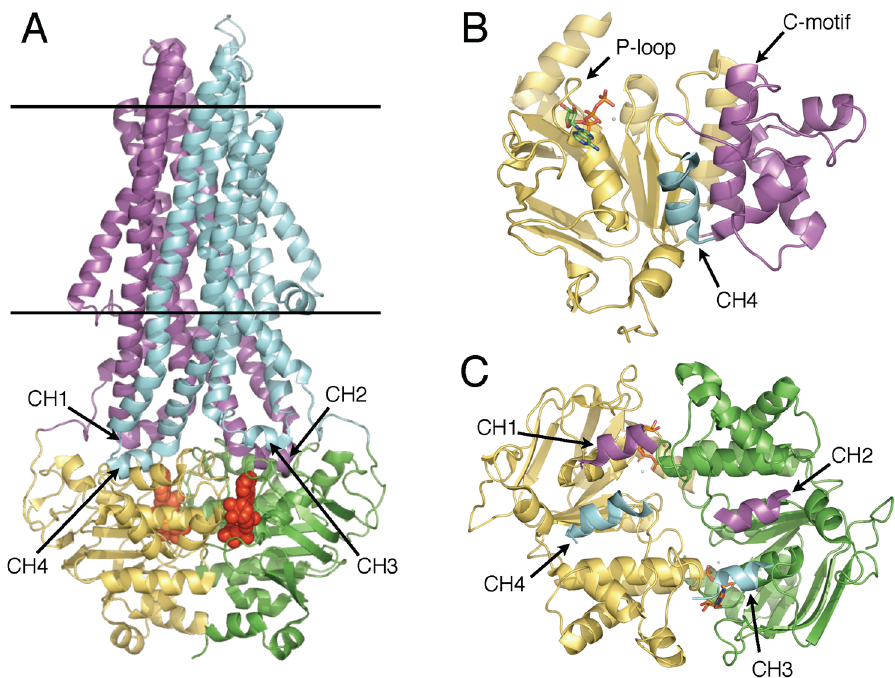
Figure 1. Structure of ABCB1 ABC Exporters. The structure of human P-glycoprotein in the ATP- bound, outward facing conformation (PDB ID: 6C0V) is illustrated in cartoon representation. ( A ) View from the plane of the membrane, approximately along the plane of the NBD dimer interface, with predicted limits of the membrane shown in black horizontal bars. Atoms of MgATP molecules shown as red spheres. TMD1 magenta, TMD2 cyan, NBD1 yellow, NBD2 green. Coupling helices of the TMDs that interface with the NBDs are indicated. ( B ) NBD1 with RecA-like domain yellow, helical domain magenta, CH4 cyan. ATP shown in stick form with oxygen red, nitrogen blue, carbon green, phosphorous gold. ( C ) NBD sandwich dimer with NBDs and CHs colored as in ( A ), with ATP molecules bound at the interface represented as in ( B ).